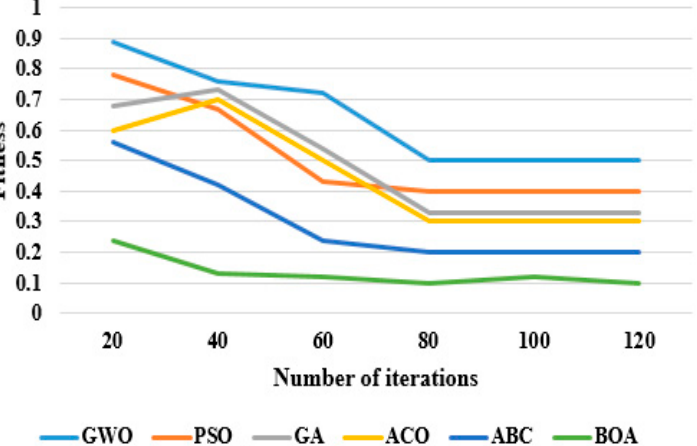
Figure 11. Fitness comparison of different optimizers achieved by varying the iteration number on the IHEPC dataset.